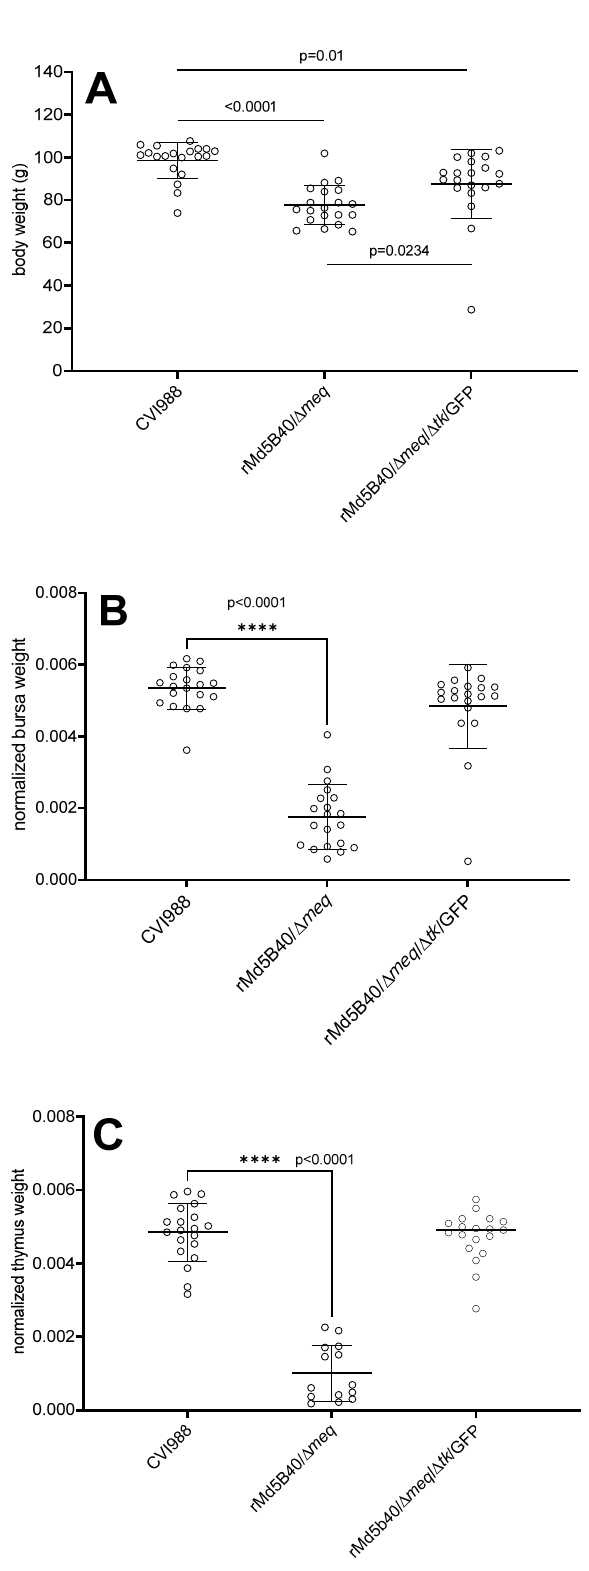
Figure 2. Ablation of the tk gene from the rMd5B40/ ∆ meq virus mitigates atrophy of the lymphoid organs. 13-day old chickens ( A ) body weight is significantly reduced with inoculation of the recombinant viruses compared to the CVI988 control, but much less in the tk -deleted recombinant. The ( B ) bursa weights and ( C ) thymus weights were normalized to body mass. In each case only the meq -ablated recombinant causes detectable atrophy of the lymphoid organs. Each recombinant virus-inoculated group is compared to the CVI988 controls. Data were compared using unpaired t-tests, (****) indicates a statistically significant difference between